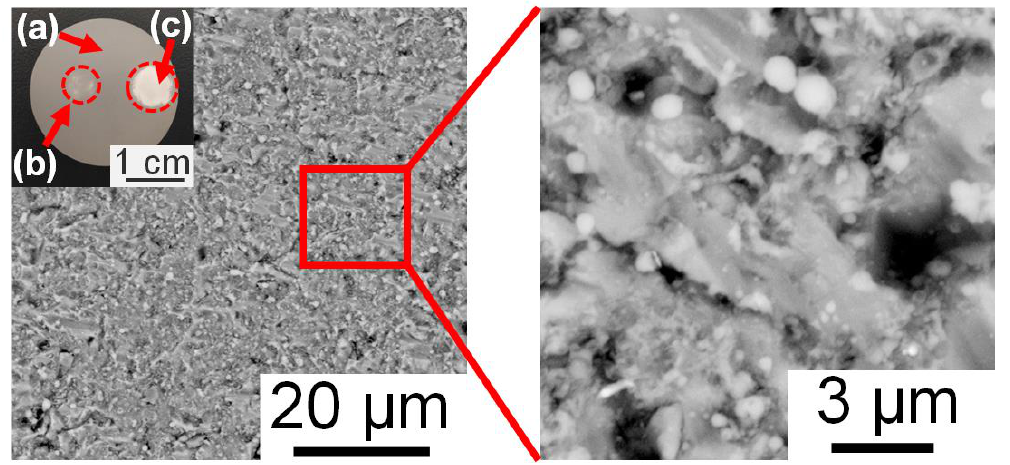
Figure 2. SEM images of the aluminum surface after the single-shot irradiation with the energy of 192 mJ. Note that (a) is the area before laser processing, (b) is the low-laser-energy treated area, and 192 mJ. Note that ( a ) is the area before laser processing, ( b ) is the low-laser-energy treated area, and (c) is the high-laser-energy treated area. ( c ) is the high-laser-energy treated